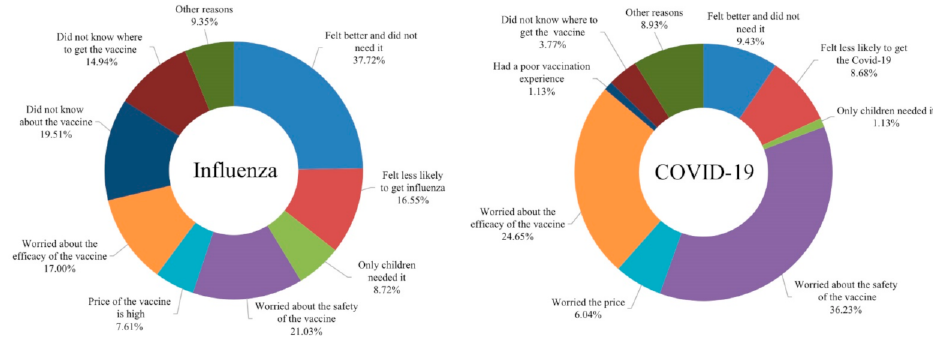
Figure 5. Reasons for not wanting to